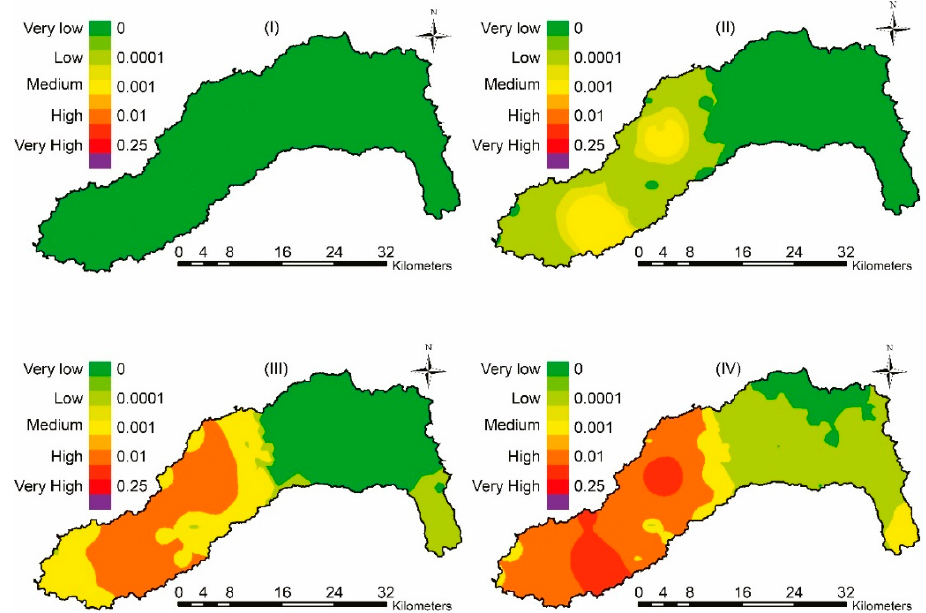
Figure 3. Leaching potential of 2,4-D in Jazan watershed as assessed by EAF index model under four leaching potential scenarios: low, 0.0003 m d − 1 (I); medium, 0.0005 m d − 1 (II); high, 0.001 m d − 1 (III); and very high recharge rate, 0.002 m d − 1 (IV).